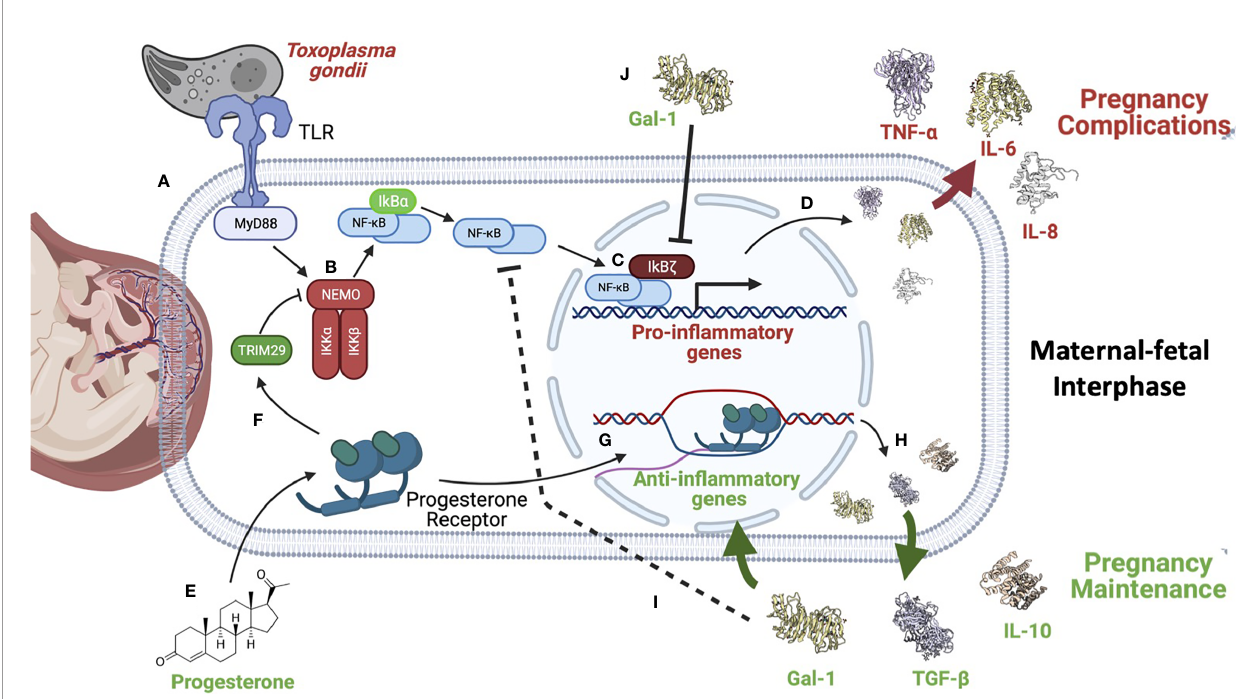
FIGURE 5 | NF- k B is a master regulator of pregnancy development. NF- k B activation can be caused by different stimuli such as pathogens like the zoonotic parasite Toxoplasma gondii infection during pregnancy. (A) This parasite is recognized by TLR-2 and TLR-4, triggering the activation of MYD88, which results in (B) the activation of the IKK complex, inducing I k B a phosphorylation and its degradation by the proteasome. Now, NF- k B free in the cytoplasm (C) can translocate itself to the nucleus where, as discussed earlier, it can be helped by its non-classical regulators, such as IkB z (D) to promote the expression of